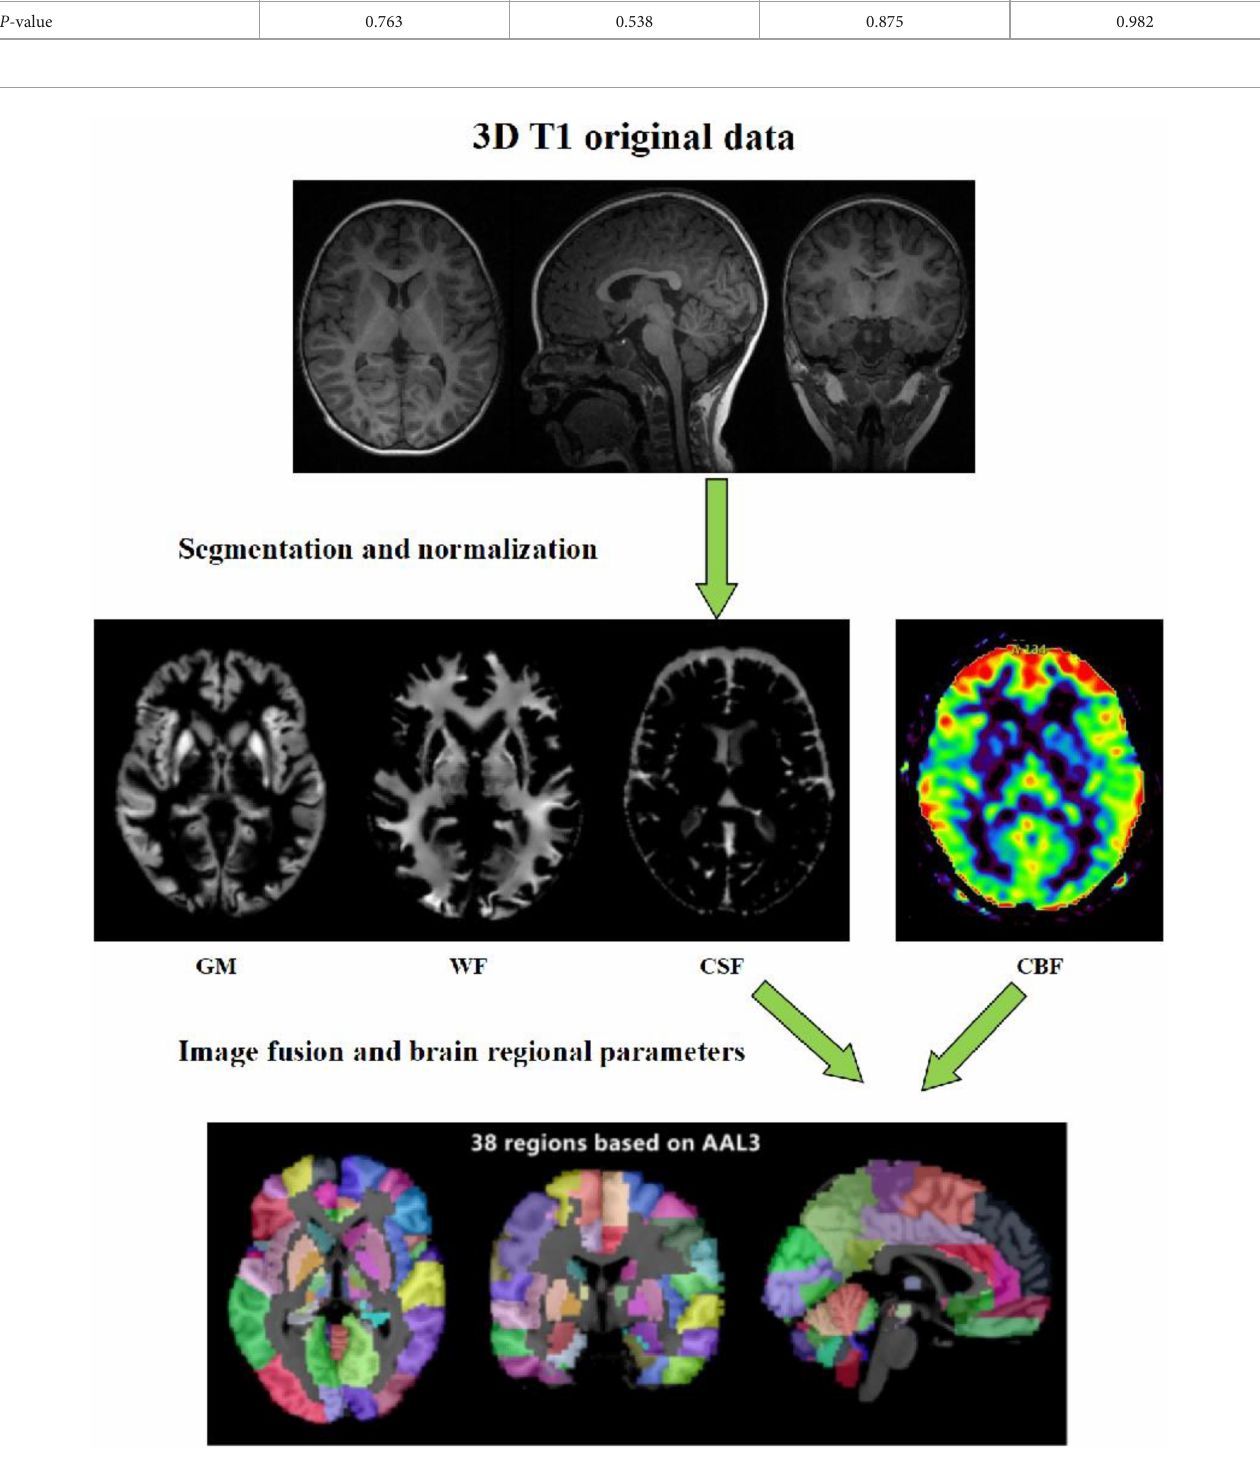
FIGURE1 Schematic diagram of the image processing and parameter